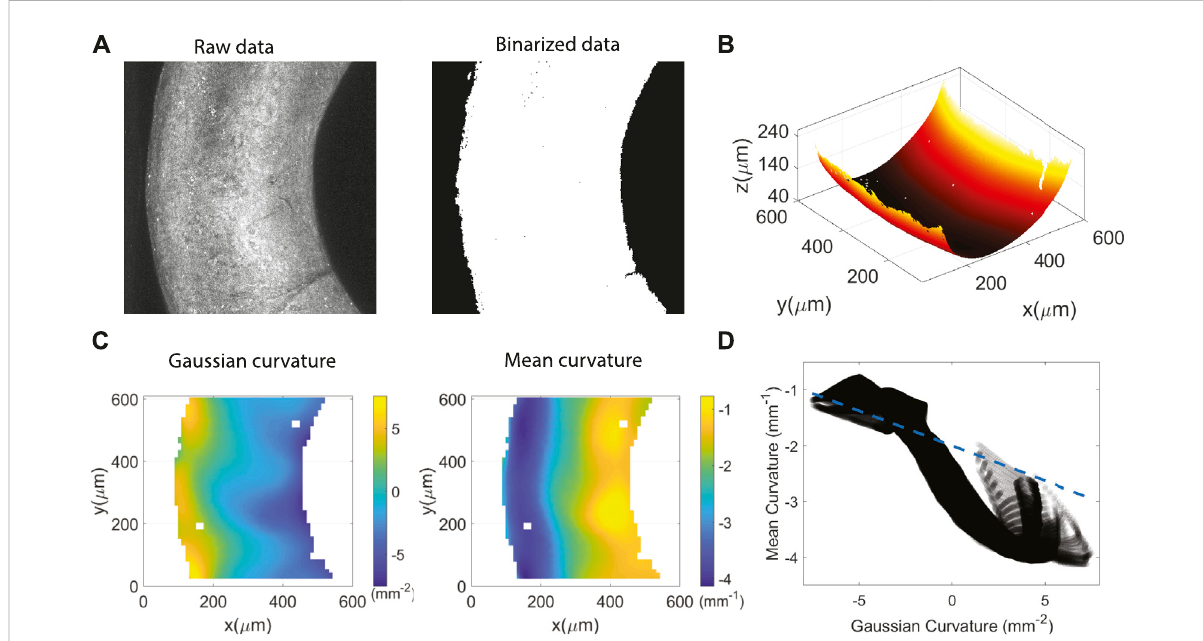
FIGURE 4 Image processing with collagen channel. The dimensions of the toroidal gels are a ≈ 0.2 mm and R ≈ 0.7 mm (aspect ratio ζ = R / a = 3.5) as measured by fi tting circles to bright fi eld images of multiple tori. (A) Maximum intensity projection of the raw data and the binarized data after thresholding. (B) 3D view of the interpolated and smoothed surface from locating the lowest point of each xy-postion through the entire image stack. (C) Gaussian and mean curvatures of the surface. (D) Gaussian versus mean curvature of every point on the surface. The dashed line represents the theoretical relationship between H and K for a torus with a tube radius of 250 μ m and a ring radius of 800 μ